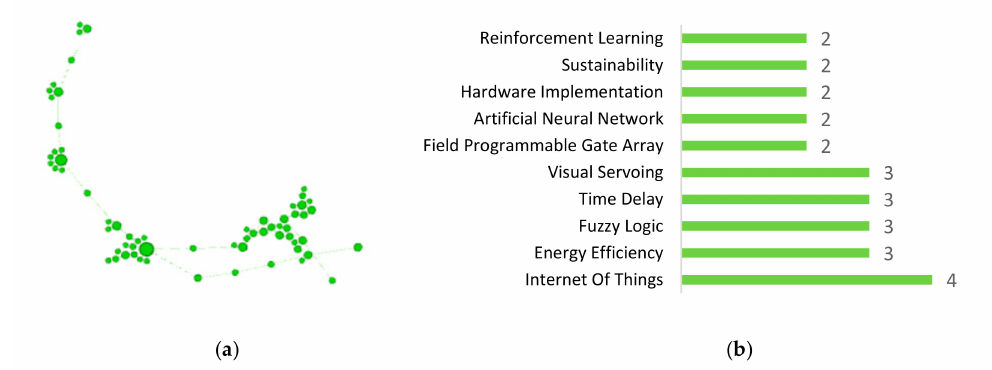
Figure 17. Representation of the New Methods community: ( a ) Isolated distribution of publications. ( b ) Keywords of the